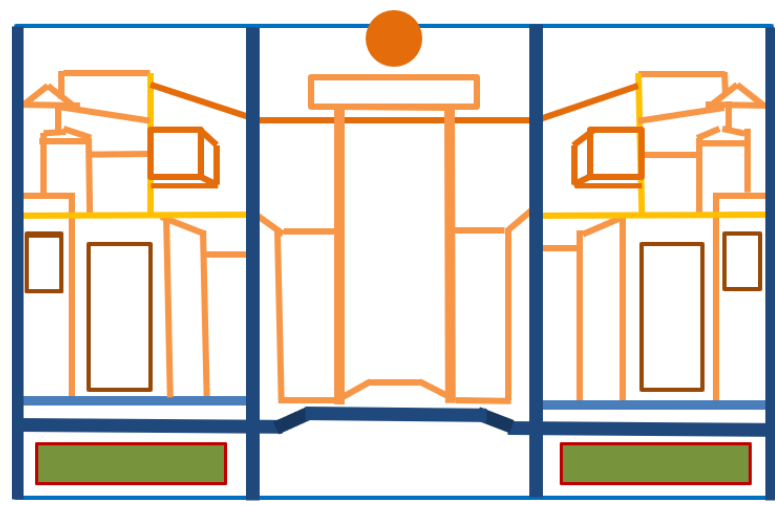
Figure 18. Guidelines removed, etc. Source: the author.